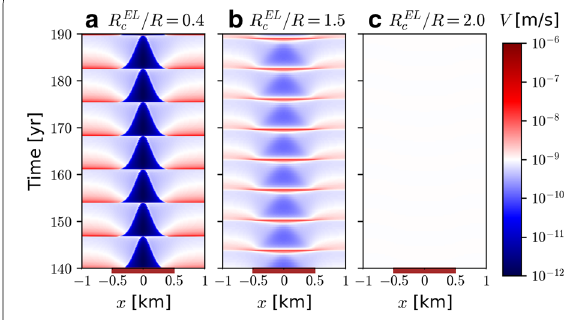
Fig. 3 Spatiotemporal distribution of V in elastic cases with different R EL c / R values. a R EL c / R = 0.4 . The system produces repeating earthquakes approximately every 7.15 years ( = 3.38 t load ). b R EL c / R = 1.5 . V max is smaller than 0.1 m/s. Repeating AT occur around the patch. c R EL c / R = 1.5 . Variation in V cannot be recognized in the color scale adopted. The steady-state solution is